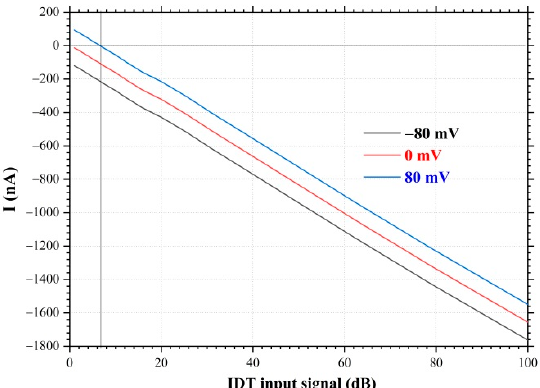
Figure 6. Dependences of current in graphene film versus amplitude of the input signal supplied to IDT (in dB). 𝑌𝑍 − cut of a LiNbO 3 crystal, Λ = 30 μ m, 𝑓 (cid:2868) = 114.5 MHz, 𝑉 = 3420